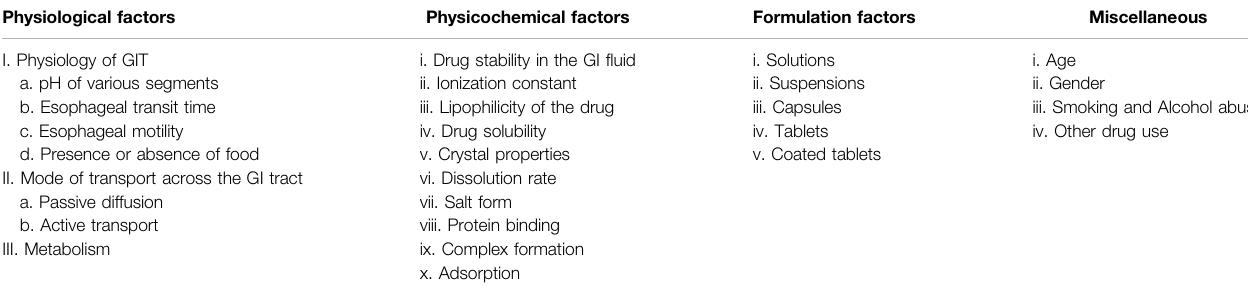
TABLE 3 | Factors that affect drug absorption from the gastrointestinal tract. Physiological